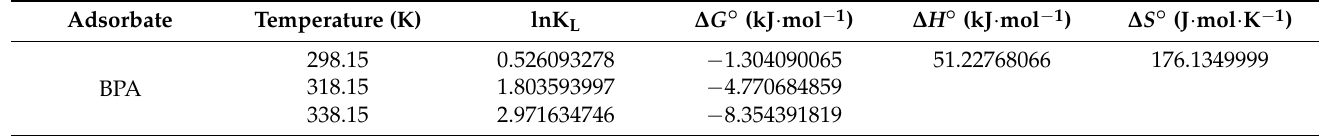
Table 6. Computed thermodynamic variables for BPA adsorption on MBC at varying temperature.